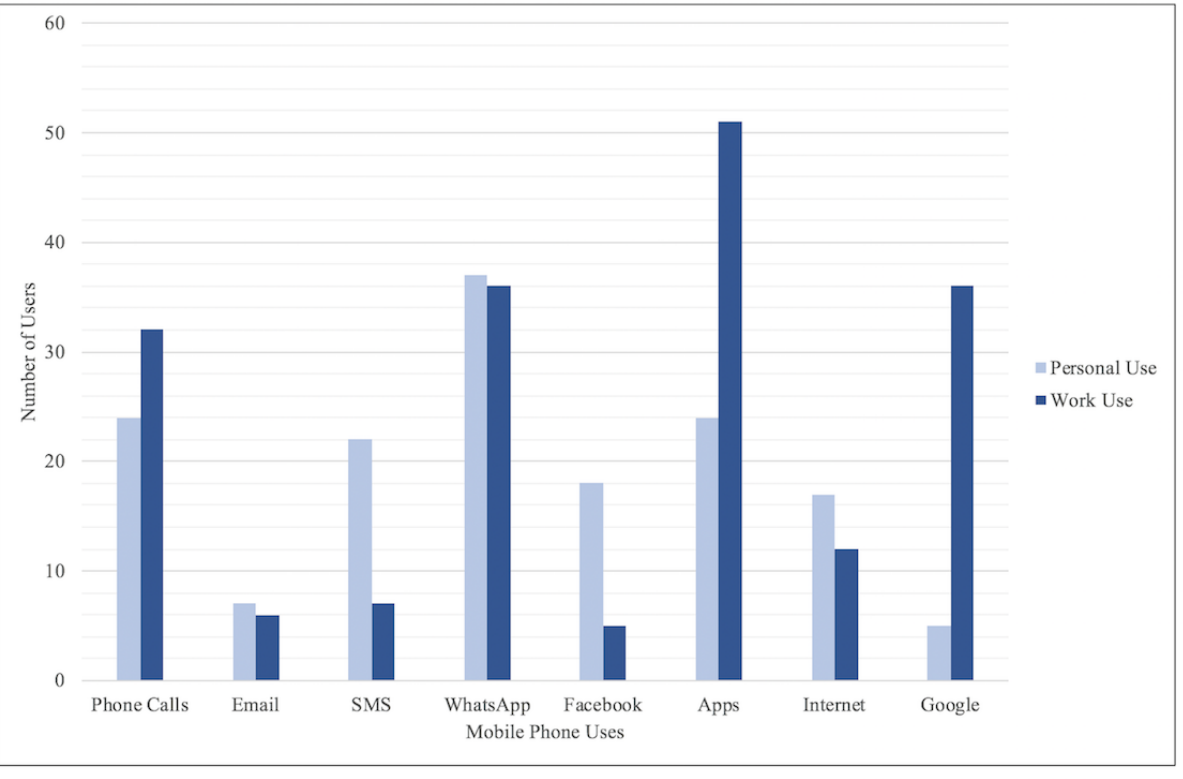
Figure 3. Common mobile phone uses. SMS: short message service.